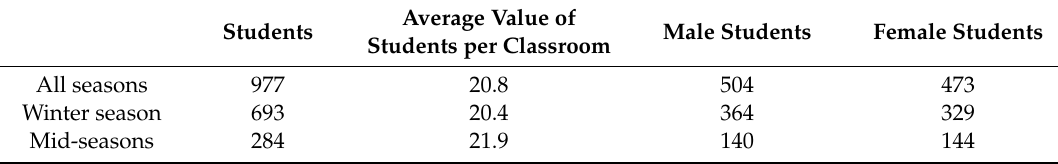
Table 4. Students participating in the survey campaign according to season and sex. Average Value of Male Students Female Students Students Students per Classroom All seasons 977 20.8 504 473 Winter season 693